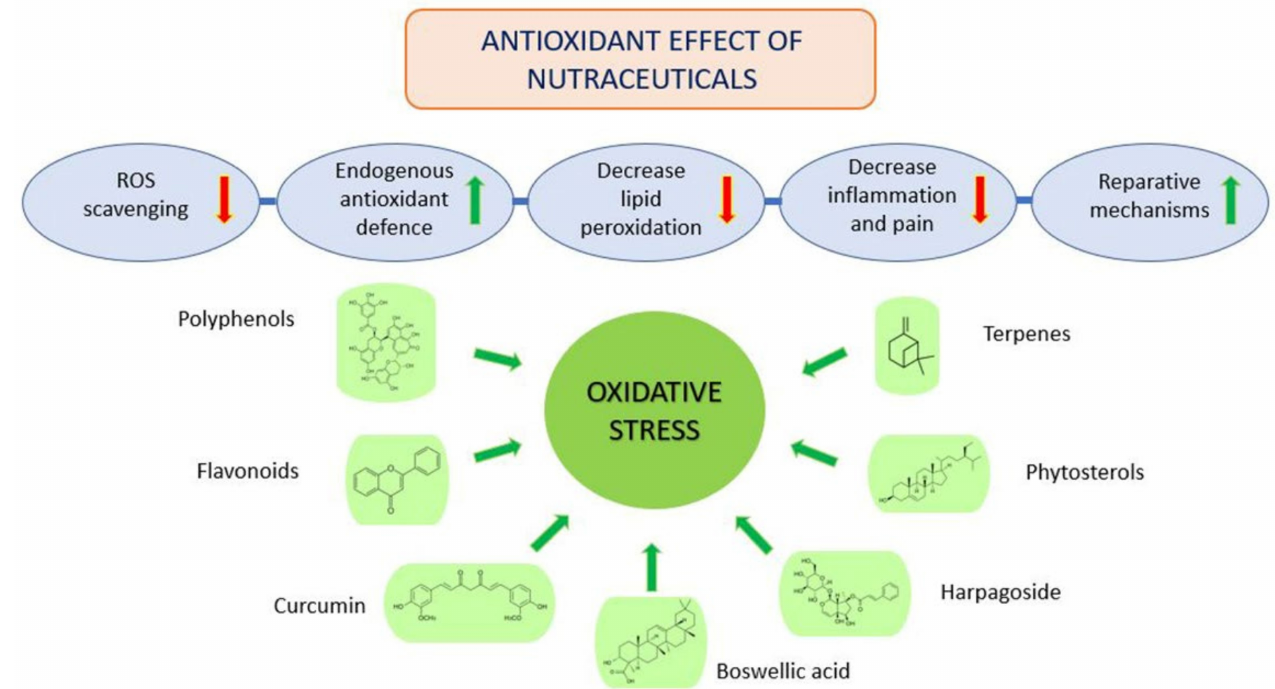
Figure 2. Oxidative stress protection